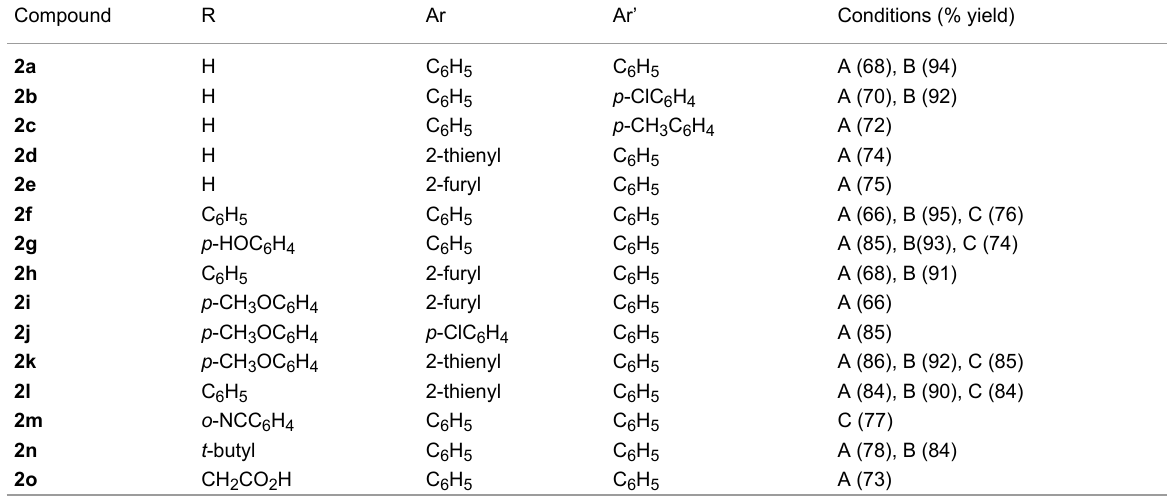
Table 1: Synthesis of dihydropyridine derivatives 2a – o , reaction conditions and % yield.